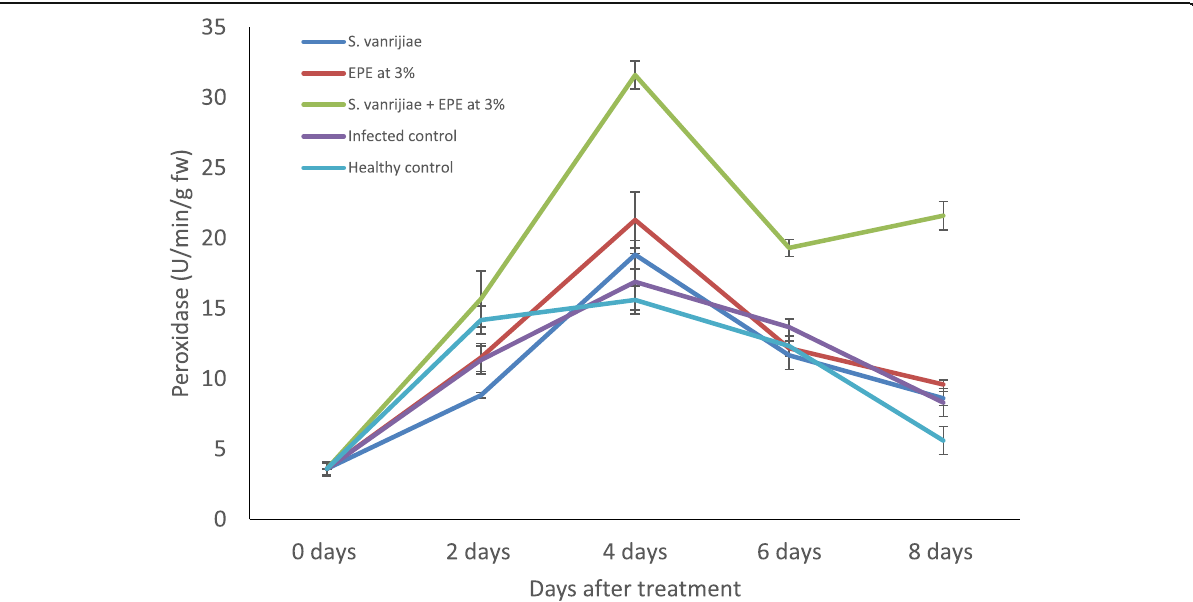
Fig. 3 Time course of peroxidase activity (U/min/g fw) in extracts from lemon cv seedless limes tissues treated or not with S . vanrijiae and 3% EPE in mixture. All the values are the means of four replicates ±